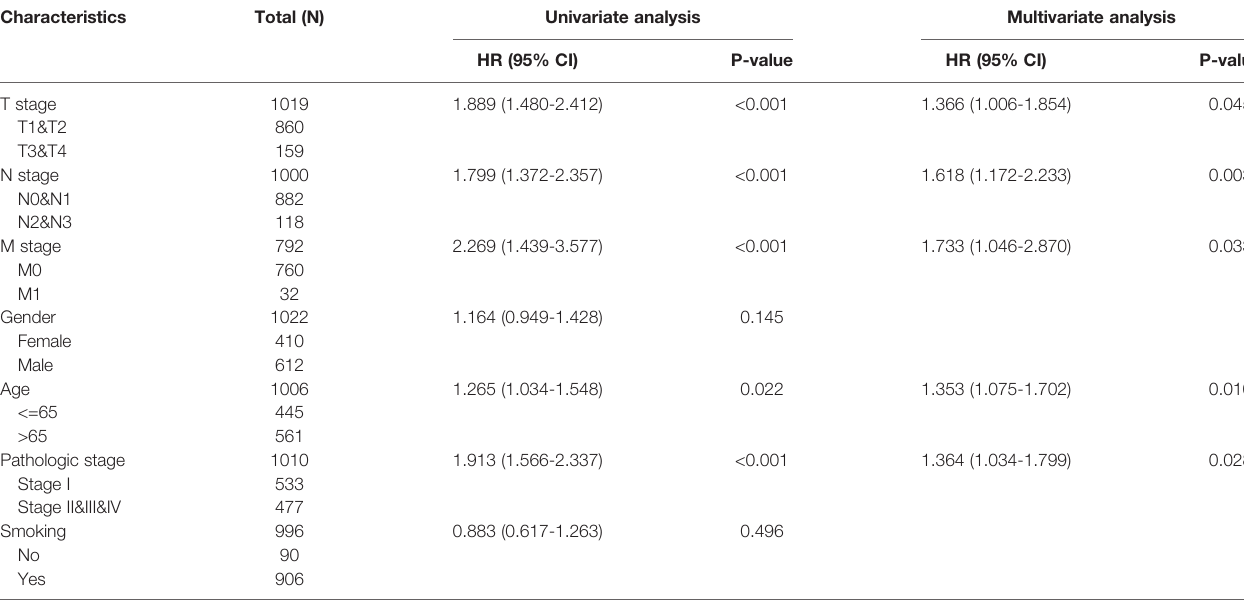
TABLE 2 | Univariate and multivariate COX analysis of clinical factors and overall survival in NSCLC.